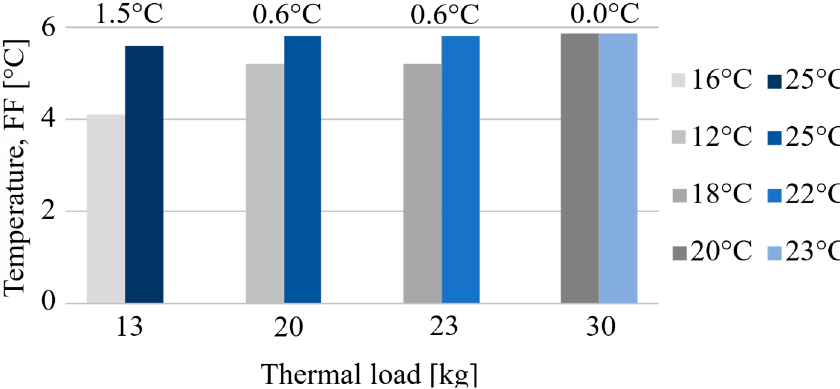
Figure 7. Temperature in the fresh-food compartment maintaining the constant thermal load at two ambient temperature conditions.